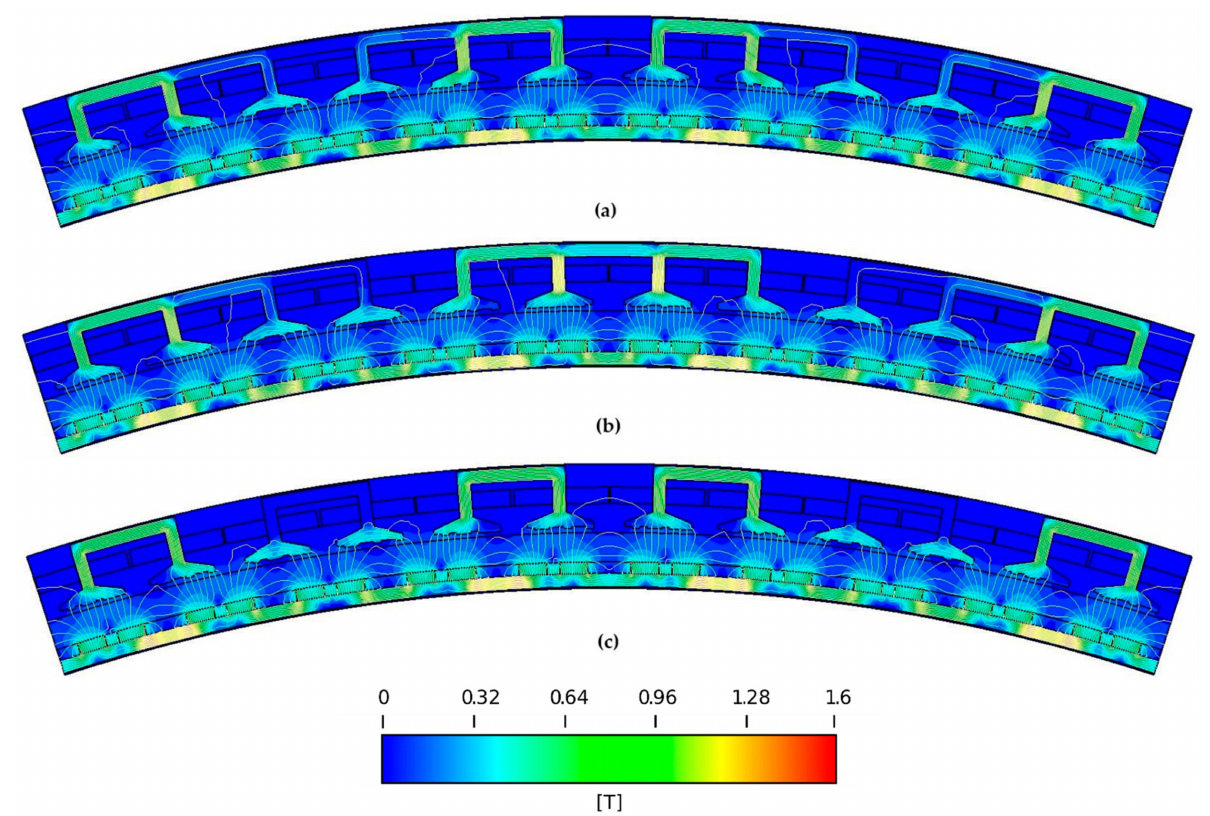
Figure 10. No-load flux density distribution of the optimized machines. ( a ) APMM with 20 stator segments, x opt = [0 0 1 1 1 0 0 1 1 0 0 0 0 1 0 1 1 1 0 1 0 0 0 0 0 1 1 1 0 1 0 0 0 0 1 1 1 1 1 0 1 0 0 0 0 0 1 0 1 1 1 0 1 0 0.8 mm]. ( b ) APMM with 30 stator segments, x opt = [0 1 1 1 1 1 1 1 1 1 0 0 1 0 0 1 1 0 0.48 mm]. ( c ) APMM with 60 stator segments, x opt =